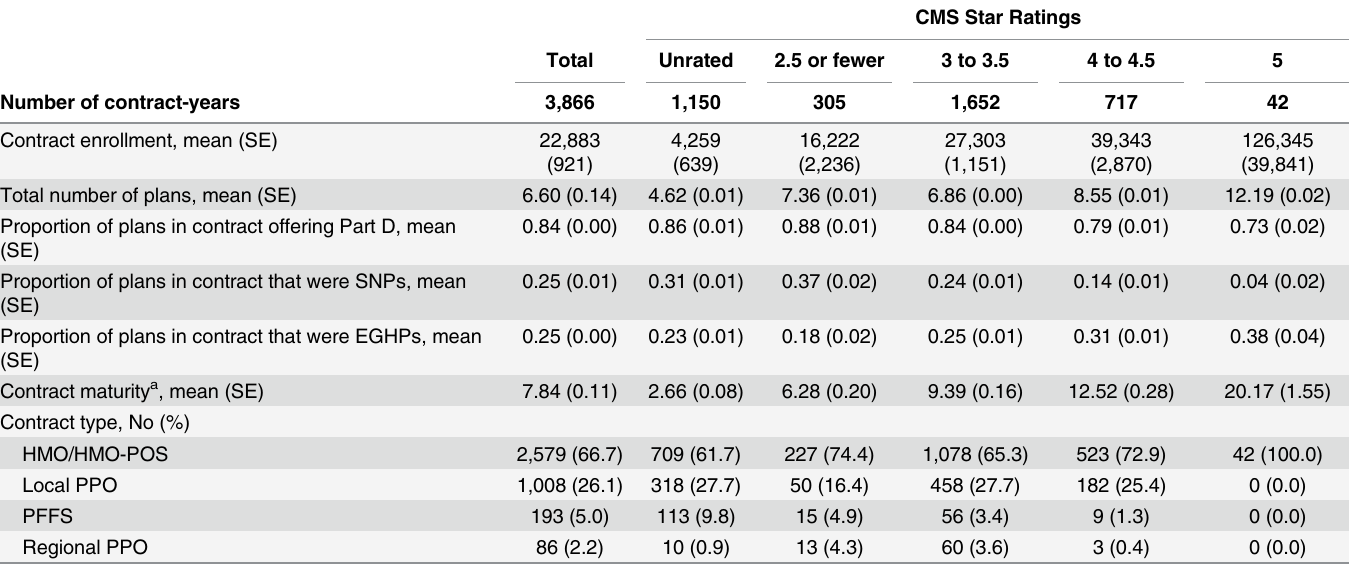
Table 1. Sample Characteristics by CMS Star